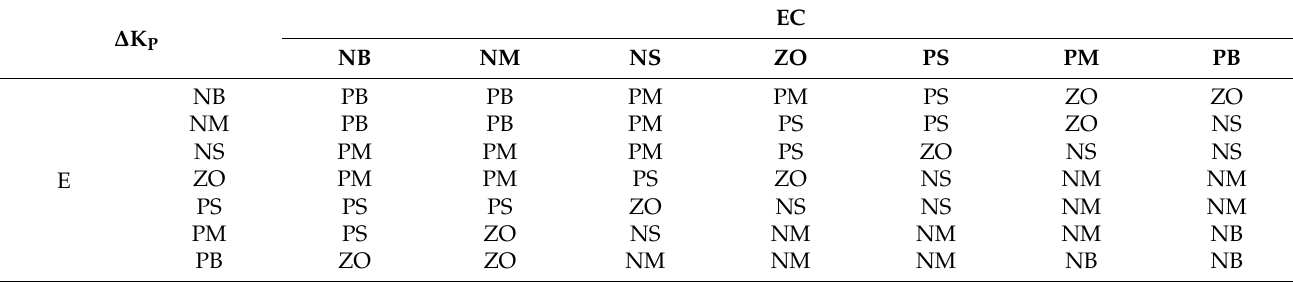
Figure 8. Gaussian membership function. Table 2. Rule of Fuzzy-PID control of ∆ K P .